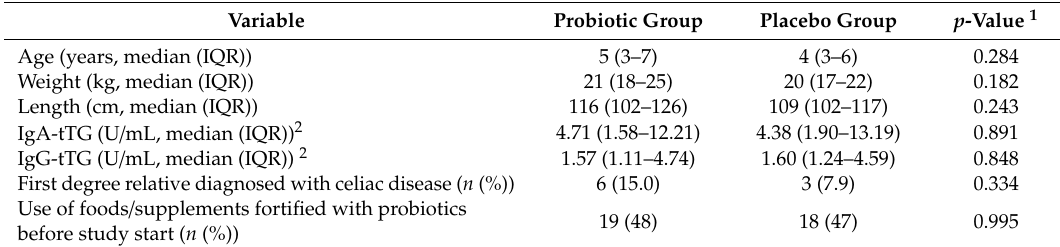
Table 1. Demographics and study-specific measures at the baseline visit. Measures are presented as the median and interquartile range (IQR), Q1–Q3.